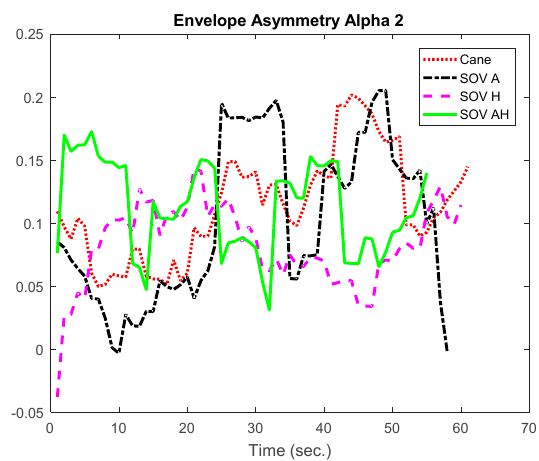
Figure 22. The average of the alpha1 asymmetry for all the users.